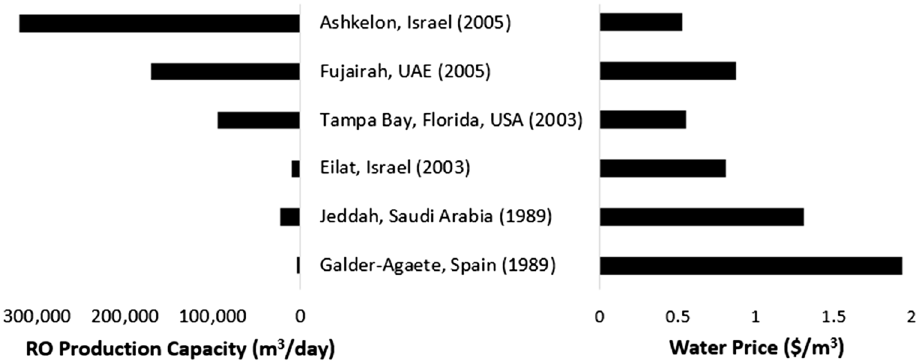
Fig. 1 RO production capacity versus water price for different RO plants